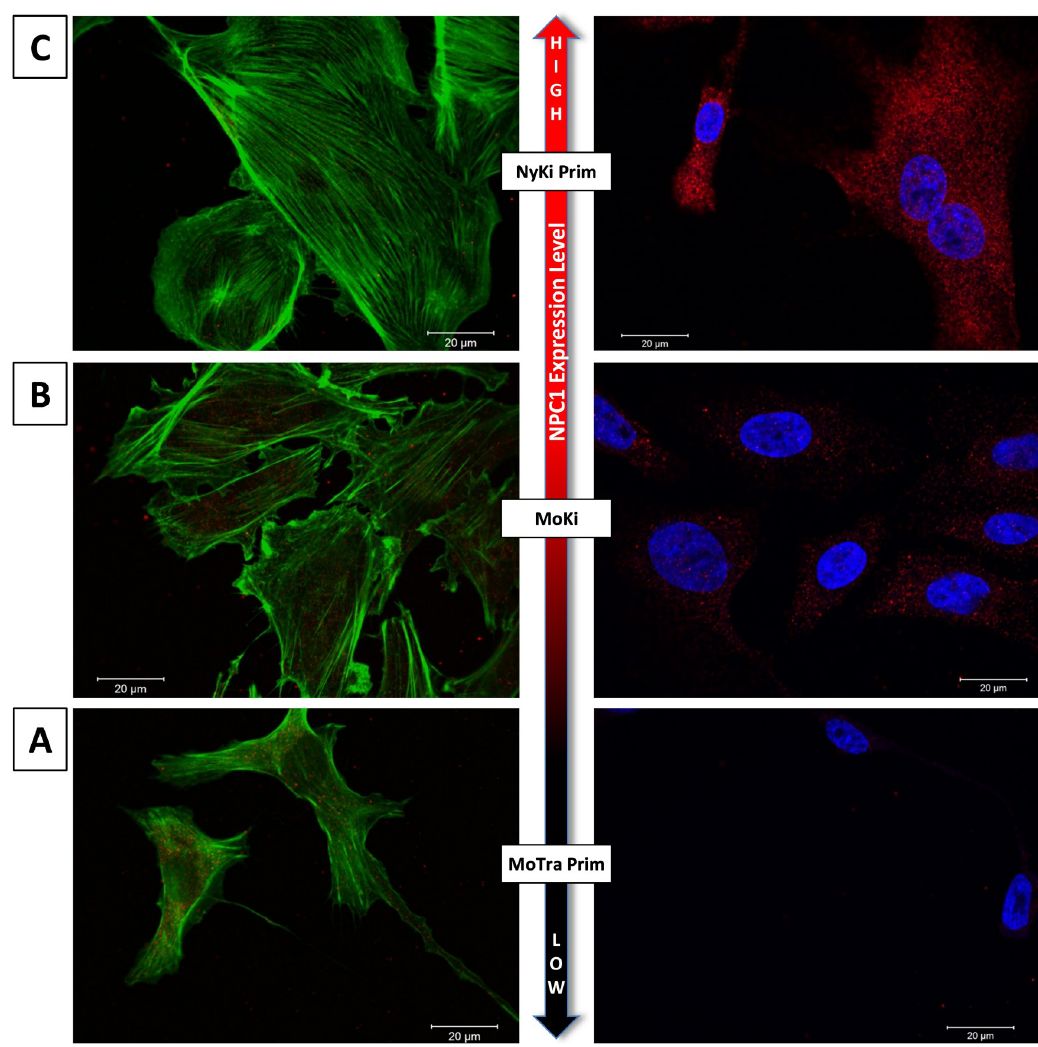
Fig 1. Comparison of NPC1 receptor expression levels in different bat cells using confocal microscopy. Left column: stained actin filaments (green). Right column: stained NPC1 receptor (red) and cell nuclei (blue). NPC1 receptor expression levels: A) MoTra Prim (low), B) MoKi (moderate), C) NyKi Prim